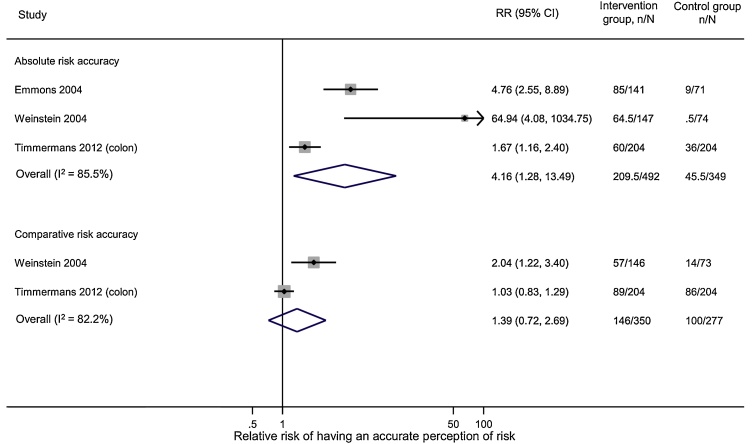
Forest plot showing the relative risk of having an accurate perception of absolute or comparative risk immediately after receiving it compared to controls who did not receive risk information.